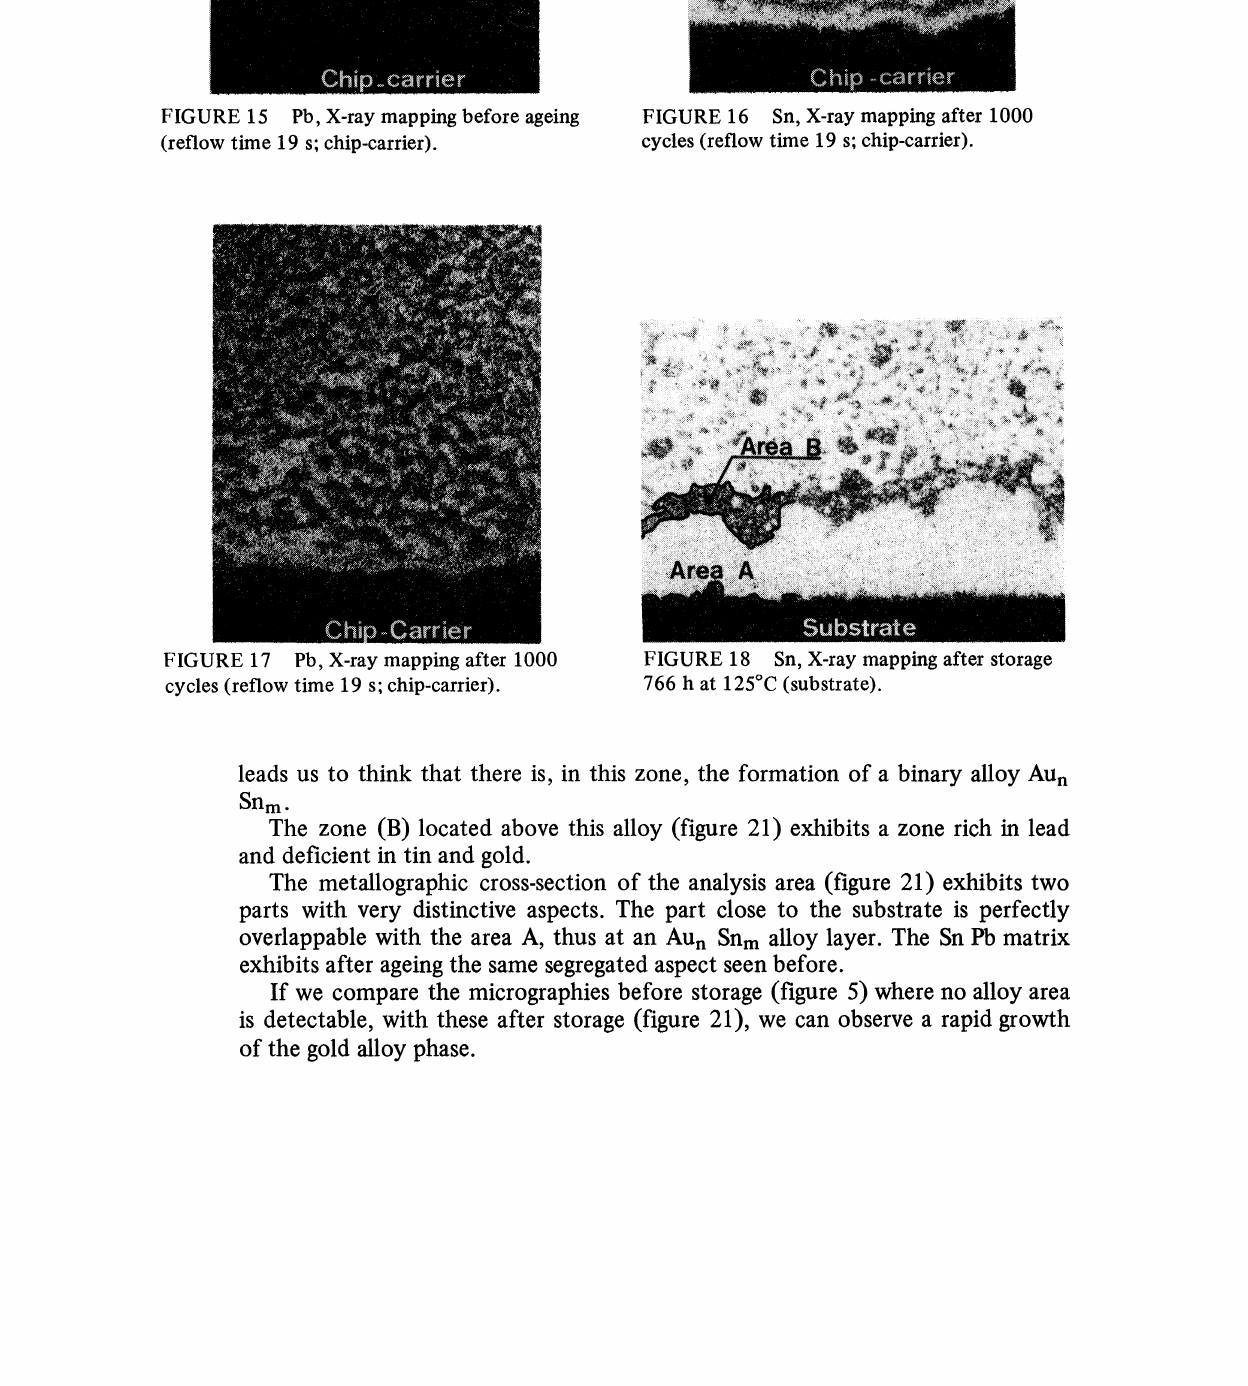
FIGURE 15 Pb, X-ray mapping before ageing (reflow time 19 s" chip-carrier).